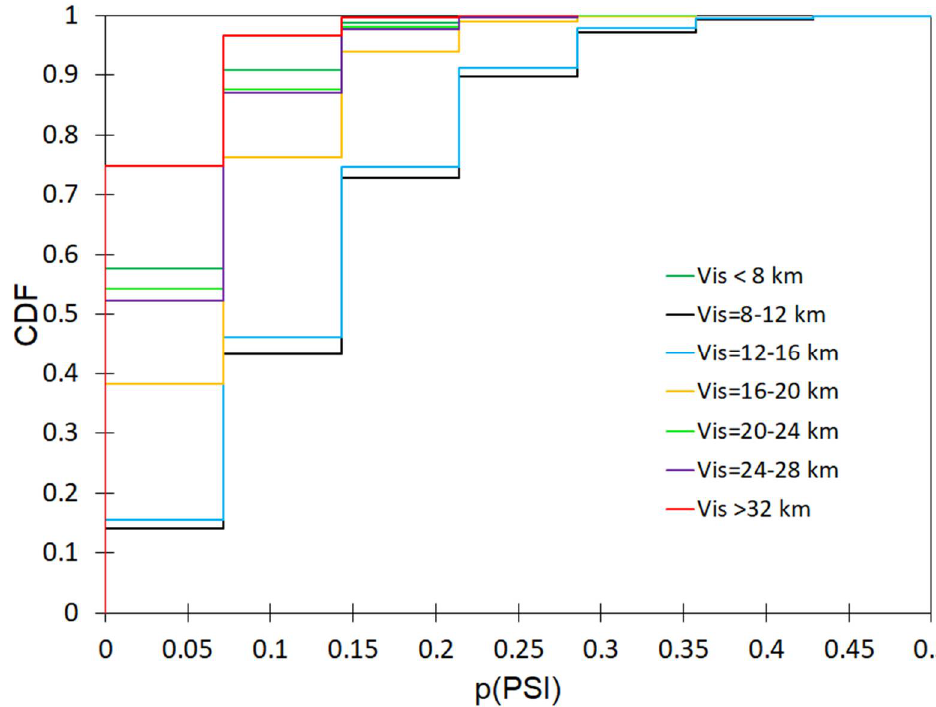
Figure A24. Effect of visibility on the incidence of low winter mortality for dry days.